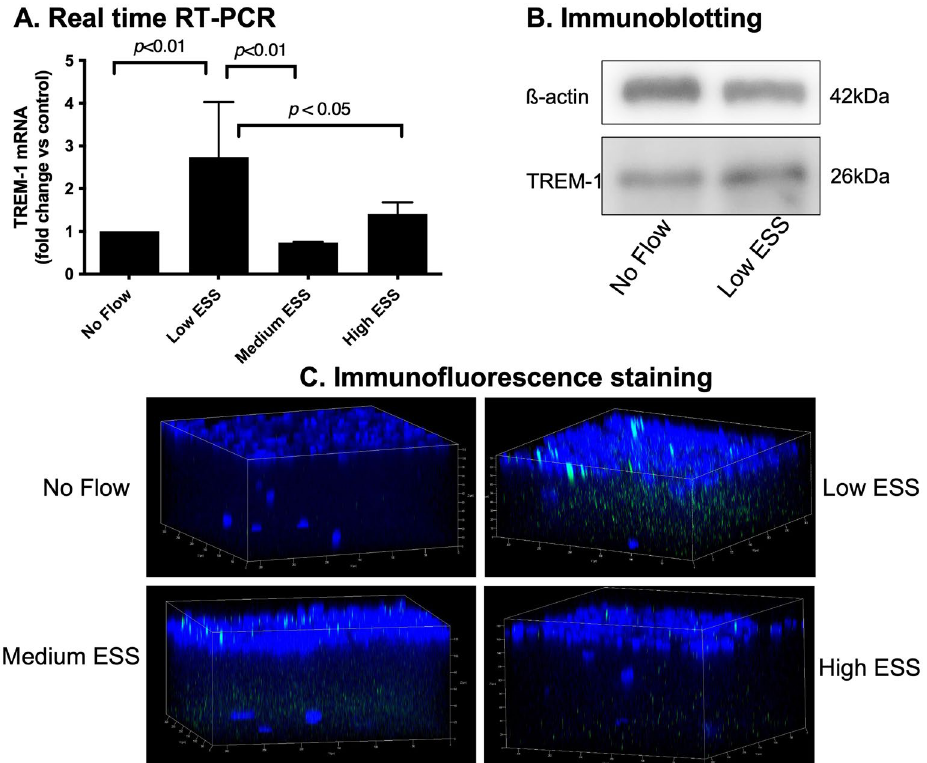
Figure 1. Effect of various shear stress conditions on the TREM-1 mRNA expression and protein synthesis in co-culture model. ( A ) Expression of TREM-1 mRNA in 3D co-culture cells exposed to low ESS, medium ESS, high ESS, and no flow (control). 3D co-culture of HCASMCs, HCAECs and monocytes (THP-1) cells were prepared on the cover slips and exposed to low ESS, medium ESS, high ESS, or no flow (control) for 1 h followed by additional culture for 1 h. Total RNA was extracted and expression of mRNA was quantified by real time RT-PCR as described in the “Methods”. ( B ) Immunoblotting of membrane-bound TREM-1 in 3D co-culture cells exposed to low ESS or no flow (control). 3D co-culture of HCASMCs, HCAECs and monocytes (THP-1) cells were prepared on the cover slips and exposed to low ESS or no flow (control) for 1 h followed by additional culture for 5 h. Total proteins of cell lysates were subjected to electrophoresis (10% SDS-12.5% PAGE gel) and immunoblotting to TREM-1 and ß-actin as described in the “Methods” ( B presents the blots at 5 h. The original blots at 5 and 24 h are presented in the Supplemental Fig. S3). ( C ) Immunofluorescence staining of TREM-1 in 3D co-culture cells exposed to low ESS, medium ESS, high ESS, and no flow (control). 3D co-culture of HCASMCs, HCAECs and monocytes (THP-1) cells were prepared on the cover slips and treated with low ESS, medium ESS, high ESS, or no flow (control) for 1 h followed by additional culture for 5 h.